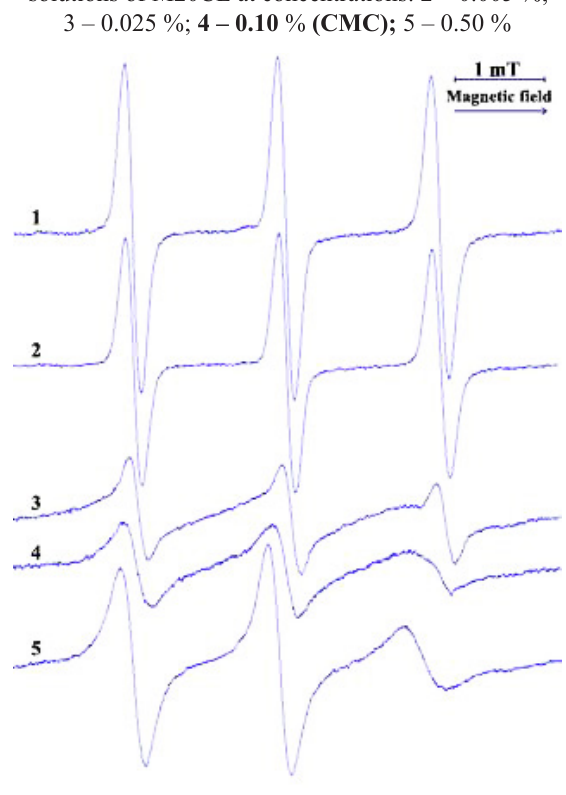
Fig. 9. EPR spectra of probe 1 in water (1) and aqueous solutions of М20СЕ at concentrations: 2 – 0.005 %;